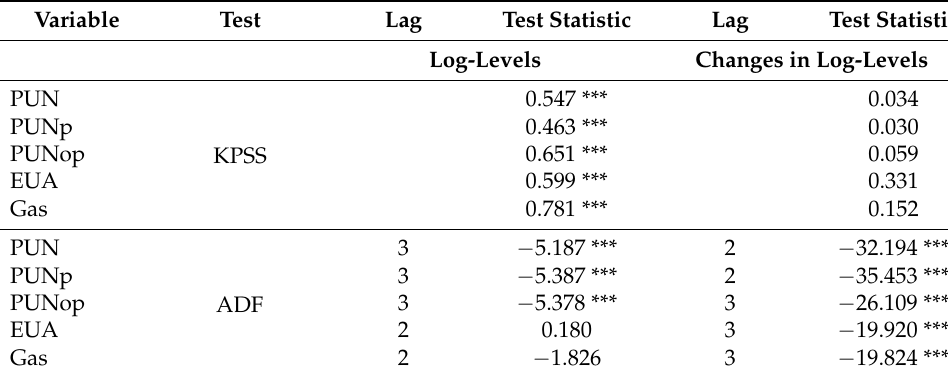
Table A2. Stationarity tests on the log-levels series.